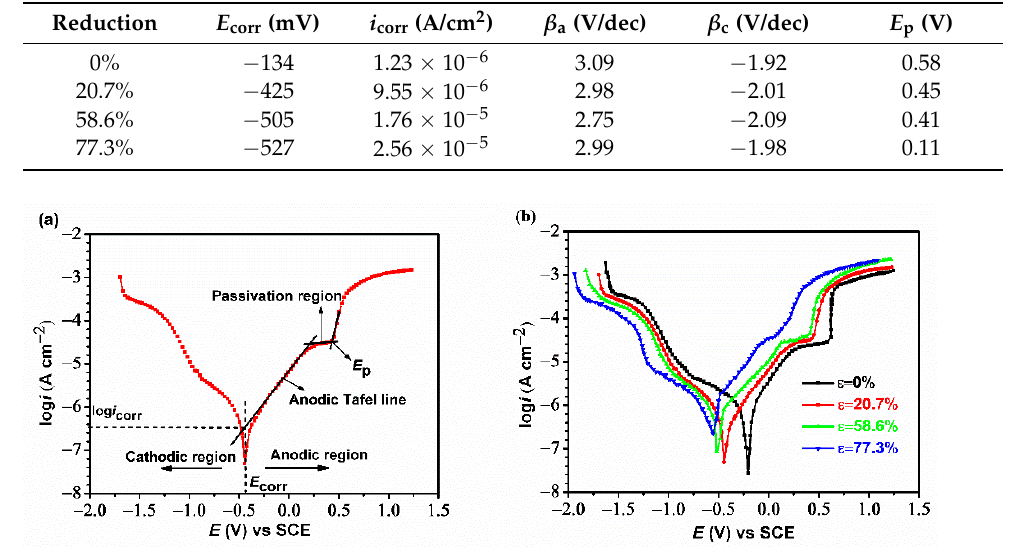
Figure 3. Potentiodynamic polarization results of Cu electrodes in the O/W emulsions: ( a ) Tafel extrapolation method of the anodic polarization curve and ( b ) polarization curves under different rolling reductions.